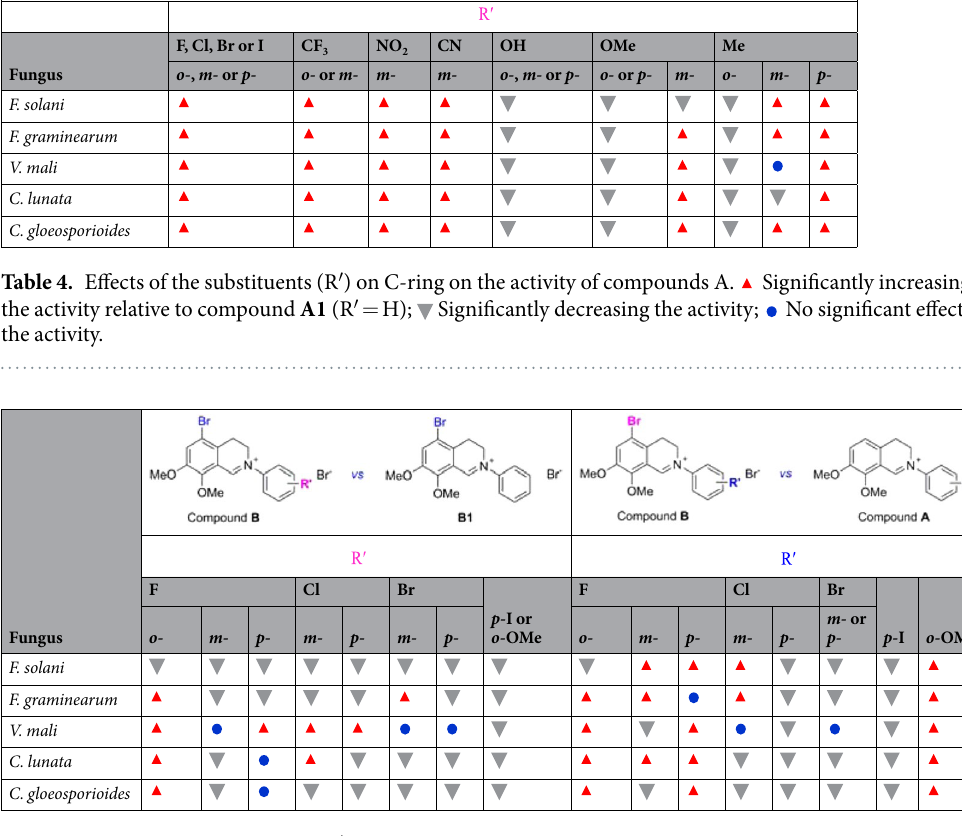
Table 5. Effects of the substituents (R ′ ) on C-ring and 5-Br on the A-ring on the activity. Significantly increasing the activity relative to compound B1 or the corresponding compounds A with the same substituents on the C-ring. Significantly decreasing the activity; No significant effect on the